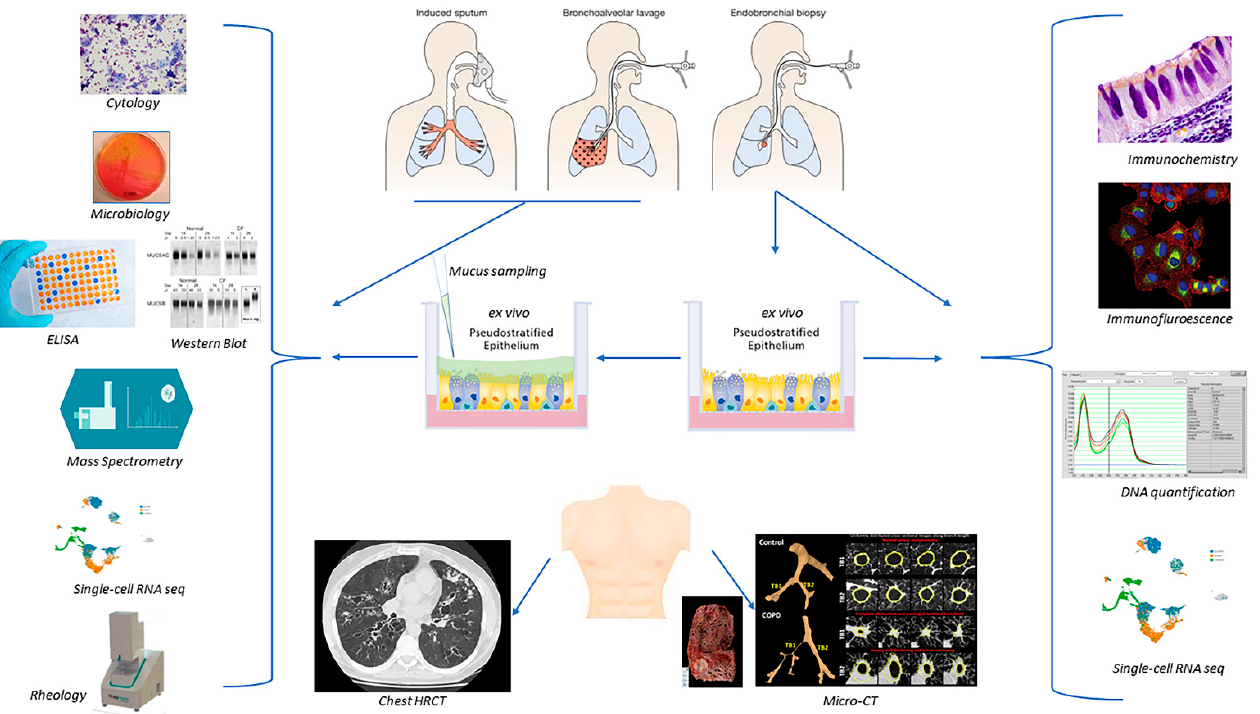
Figure 3. Summary of the main current direct and indirect techniques for assessing airway mucus and mucins. ELISA: enzyme-linked immunosorbent assay; HRCT: high-resolution computed tomography; RNA: ribonucleic acid. Table 1. Strengths and limitations of the main current direct and indirect techniques for assessing airway mucus and